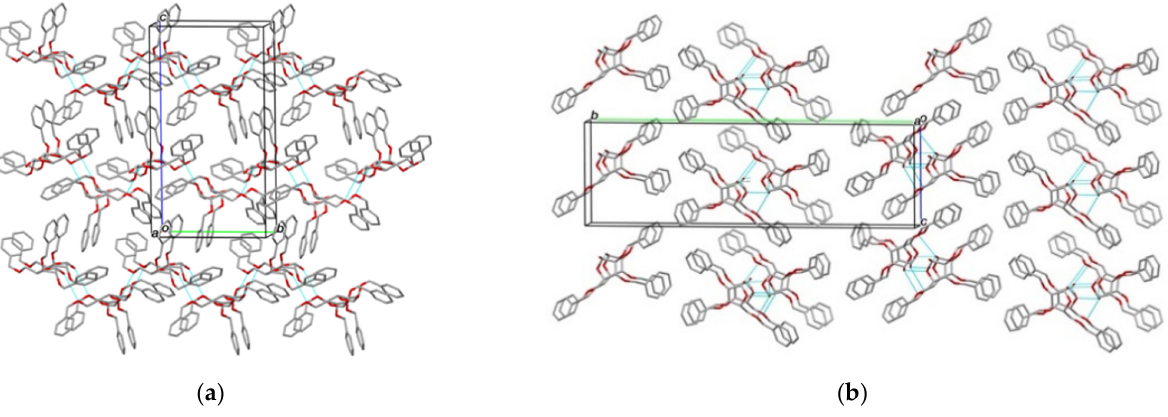
Figure 4. ( a ) Partial view of the crystal packing of ( α , β )- 1 ( ca. 89:11) along the a axis. O-H···O hydrogen bonds are shown as cyan dotted lines; ( b ) for comparison, a view of the LUHROX packing along the a axis, also highlighting the extended conformation of the homologous molecule is reported.